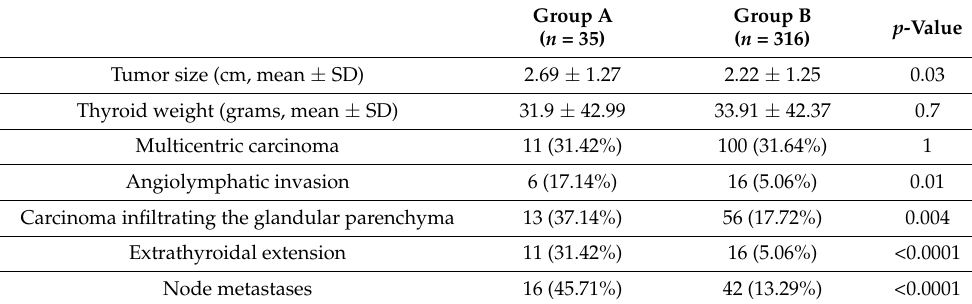
Table 3. Histopathological diagnosis.